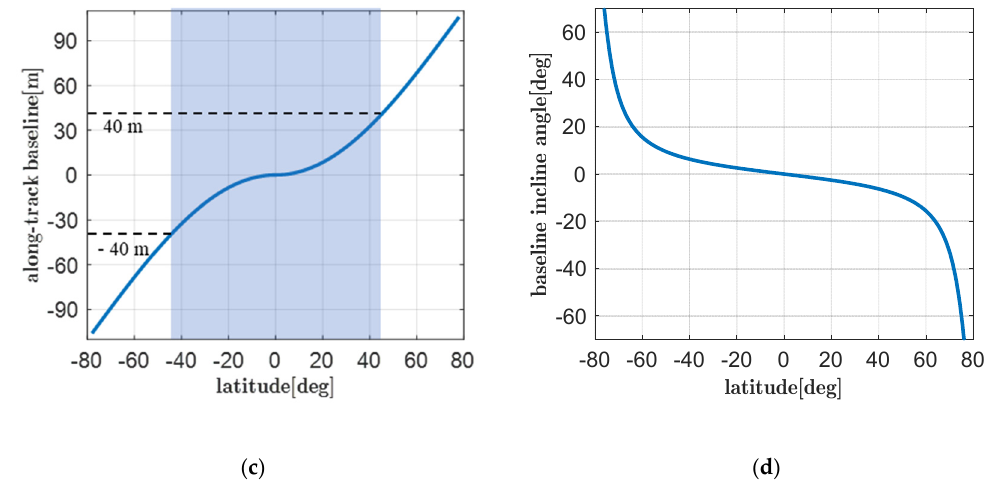
Figure 6. Real-time distance and baseline variation versus latitude during half an orbit cycle. ( a ) Real-time distance, ( b ) cross-track baseline length, ( c ) along-track baseline length, and ( d ) baseline inclination angle.